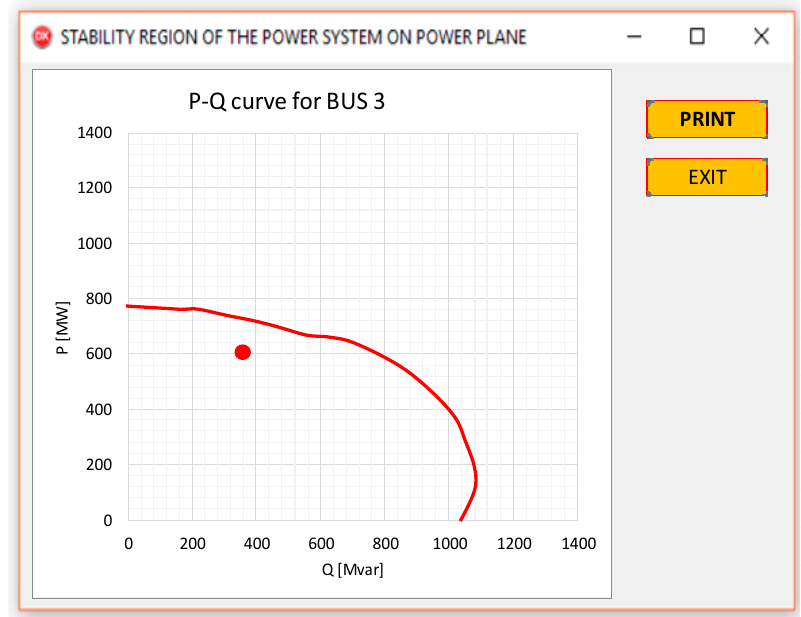
Figure 12. Operating region at Bus 3 when adjusting Q 3max .